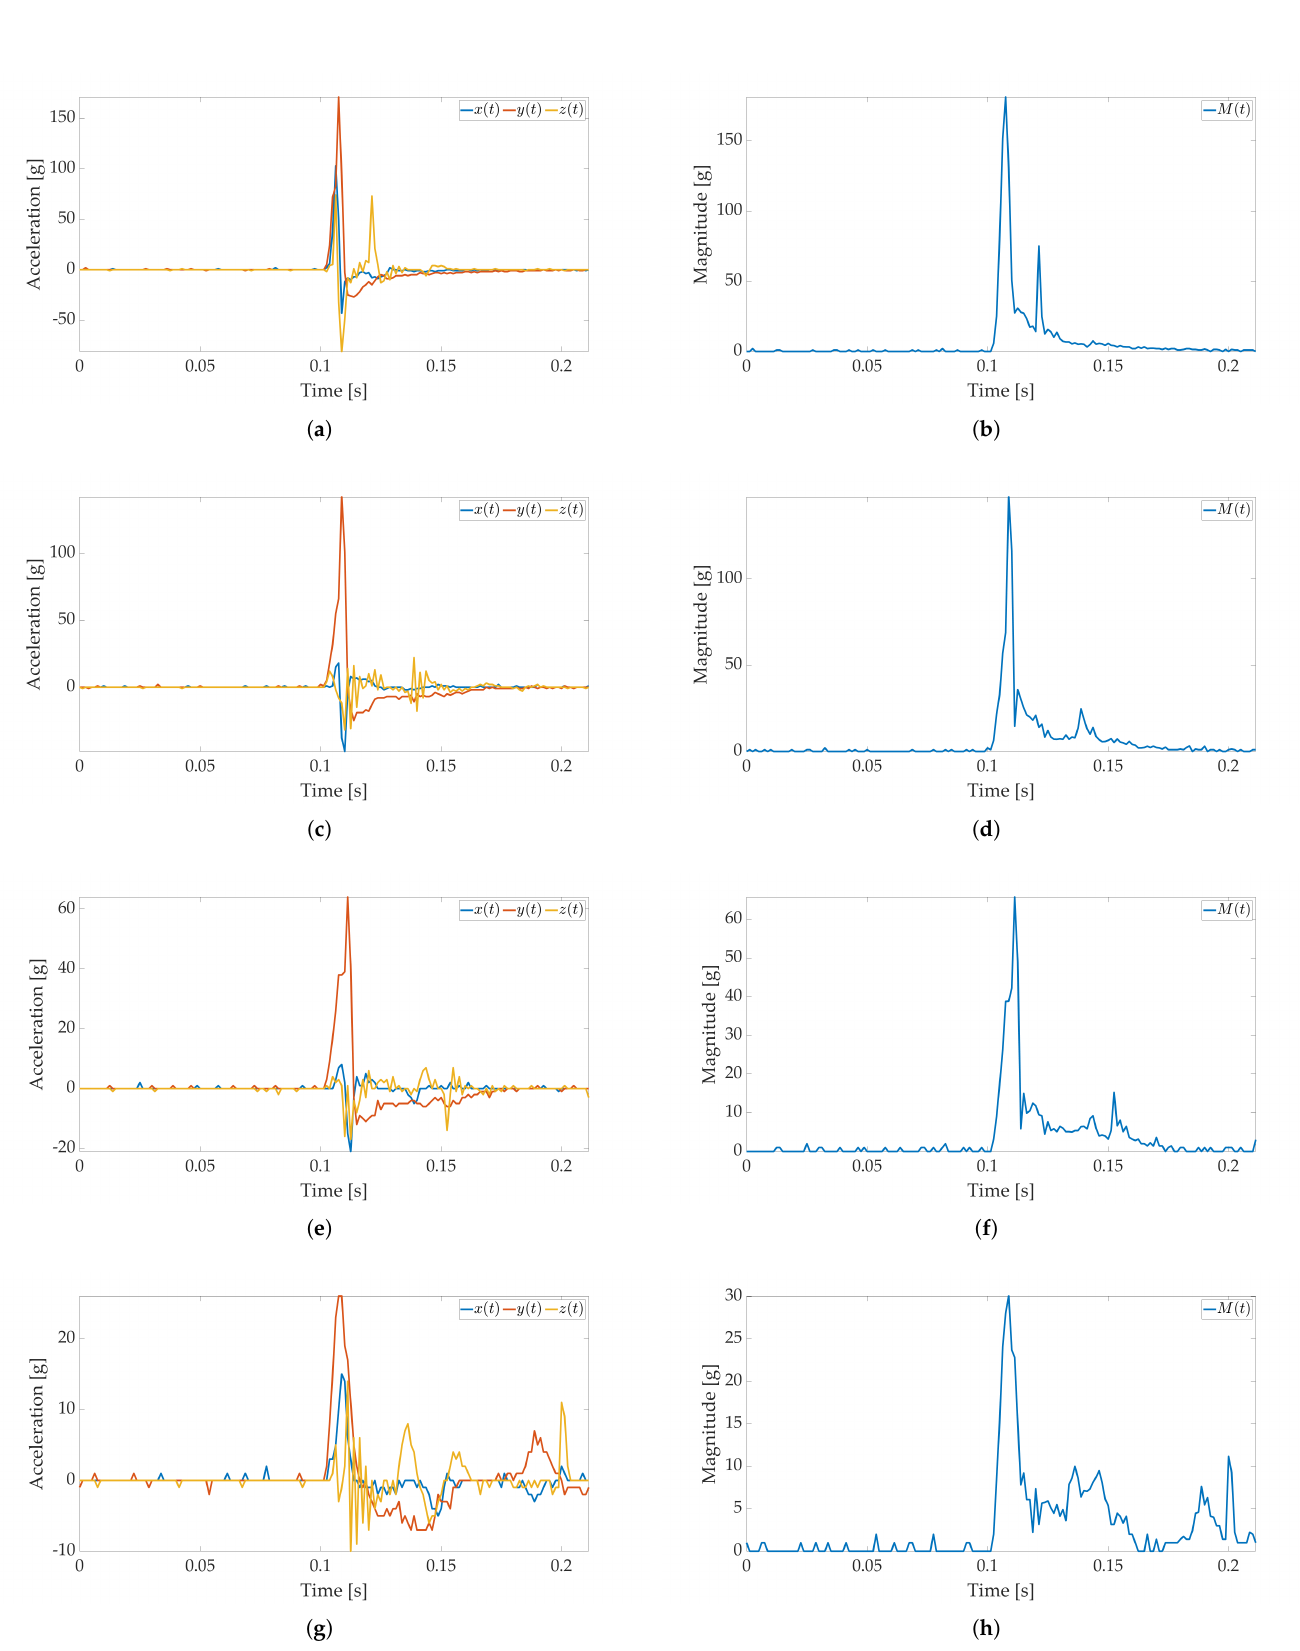
Figure 7. Shock detection values for package falling vertically from various heights (800 Hz in box without FIFO). Acceleration axes on figures ( a ) (100 cm), ( c ) (50 cm), ( e ) (20 cm), ( g ) (10 cm) and acceleration magnitude waveform on figures ( b ) (100 cm), ( d ) (50 cm), ( f ) (20 cm), ( h ) (10